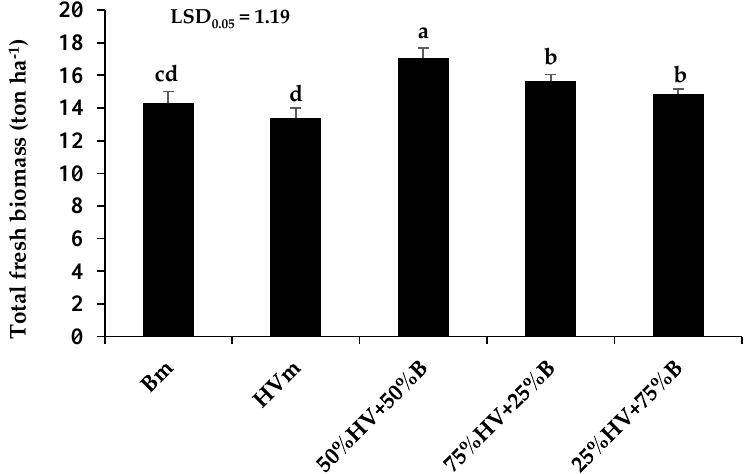
Figure 1. The total fresh biomass of green manures that returned into soil at flowering stage (average of two years). Bm (Barley monoculture); HVm (hairy vetch monoculture); 50%HV + 50%B, 75%HV + 25%B and 25%HV + 75%B (different intercrop ratios of hairy vetch/barley). Same letters above the bars do not differ significantly ( p < 0.05) according to LSD test.